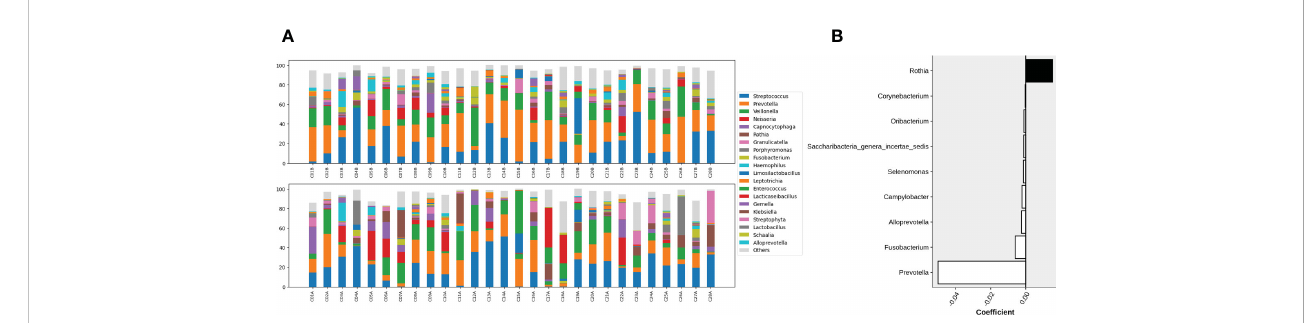
FIGURE 3 (A) Compositions of top 20 abundant genera in oral samples of group C before (top) and after (bottom) gargling. Rest genera are combined in the “ Others ” category. The space between 100% and height of each stacked bar shows the fraction of unclassi fi ed bacteria. (B) Differentially abundant genera; the +/- sign of a coef fi cient indicates an increase/decrease in the fraction after gargling and the value indicates the magnitude of